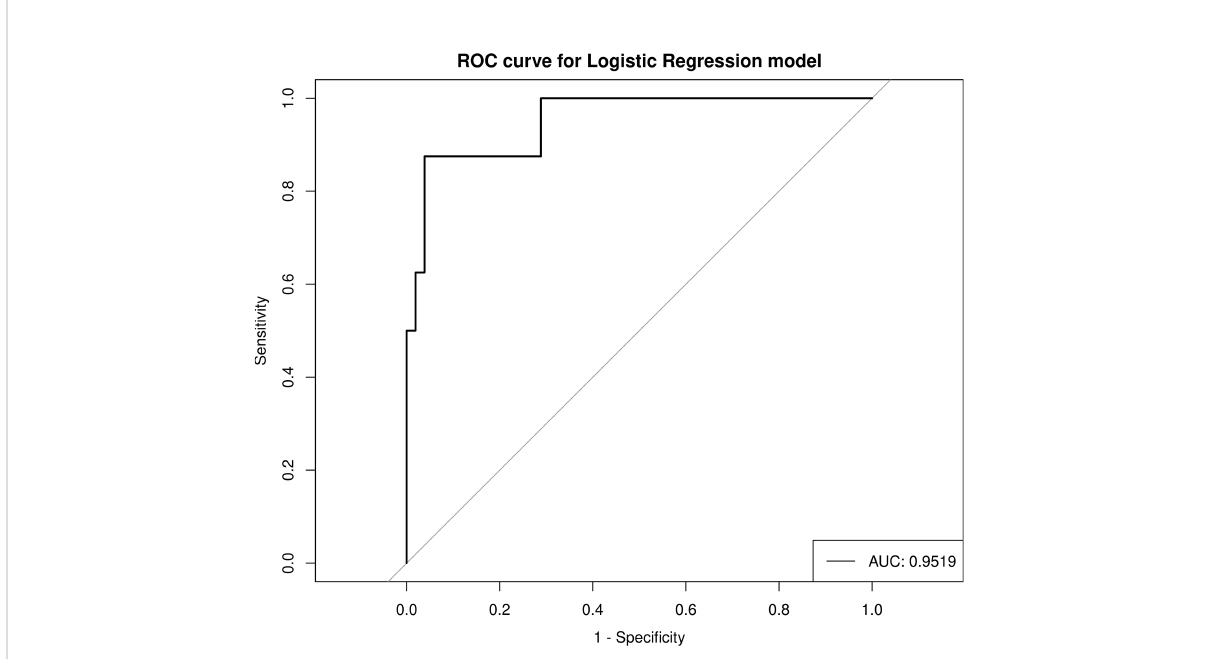
FIGURE 8 Prediction model for HIV+ and HIV- discrimination based on seven combined genera of gut microbiota. AUC, area under the curve; ROC, receiver operator characteristic curve.